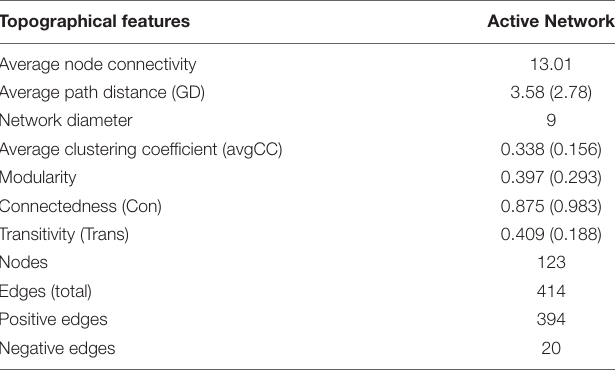
TABLE 2 | Network statistics of the potentially active hypolith community